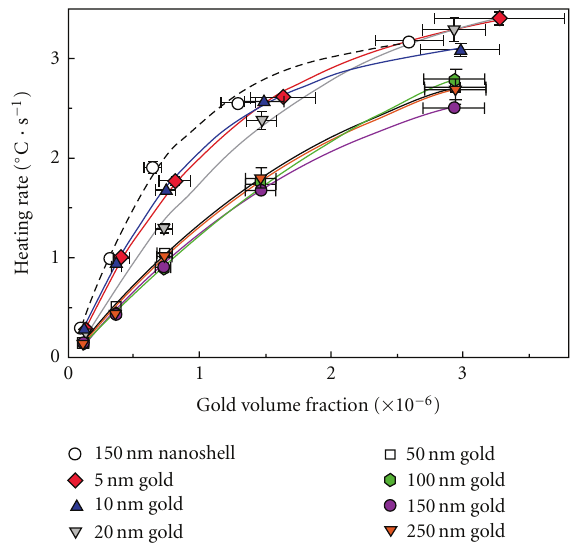
Figure 3: Size-dependent heating of gold nanoparticles in non- invasive RF field. 150nm gold nanoshells (a shell thickness of 10– 15nm) demonstrate heating rates similar to 5nm gold nanoparti- cles. Reproduced with permission from Nano Research, vol. 2, no. 5, pp. 400-405,